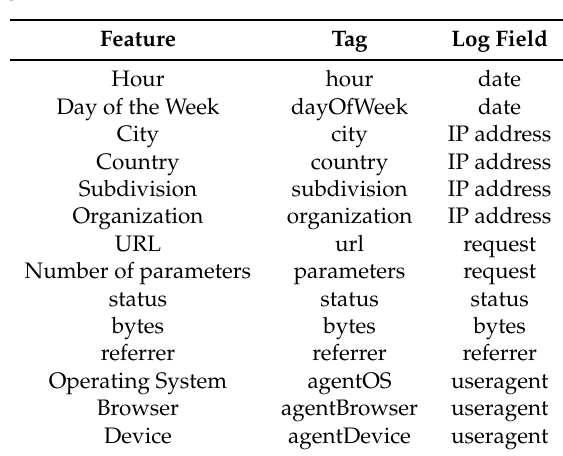
Table 2. Feature Set. The first column lists the features that will be used in our analysis. The second column lists the name used to identify the feature in the patterns. The third column specifies the origin of the feature in the logfile.